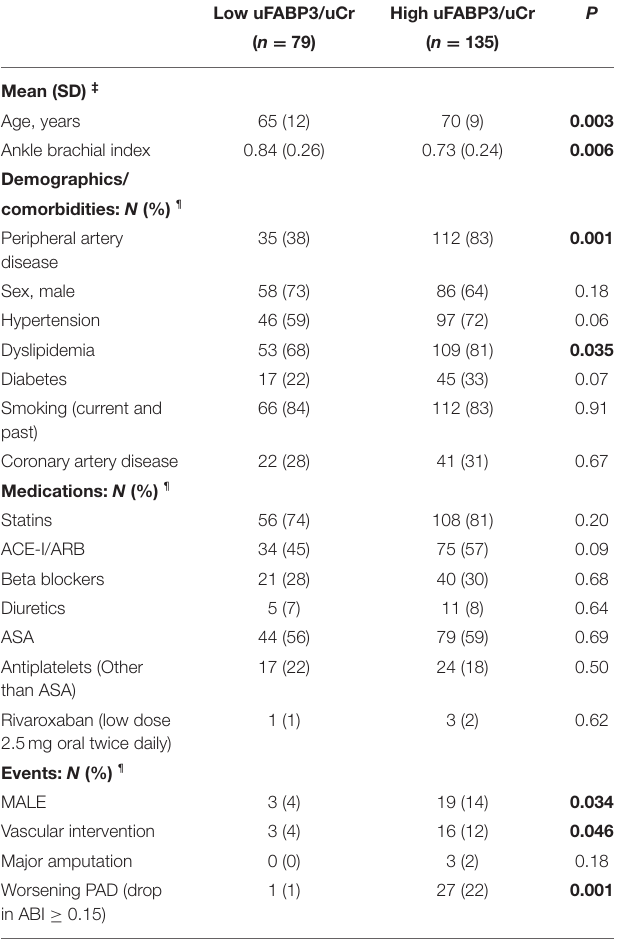
TABLE 4 | Demographic and clinical characteristics of patients with low and high